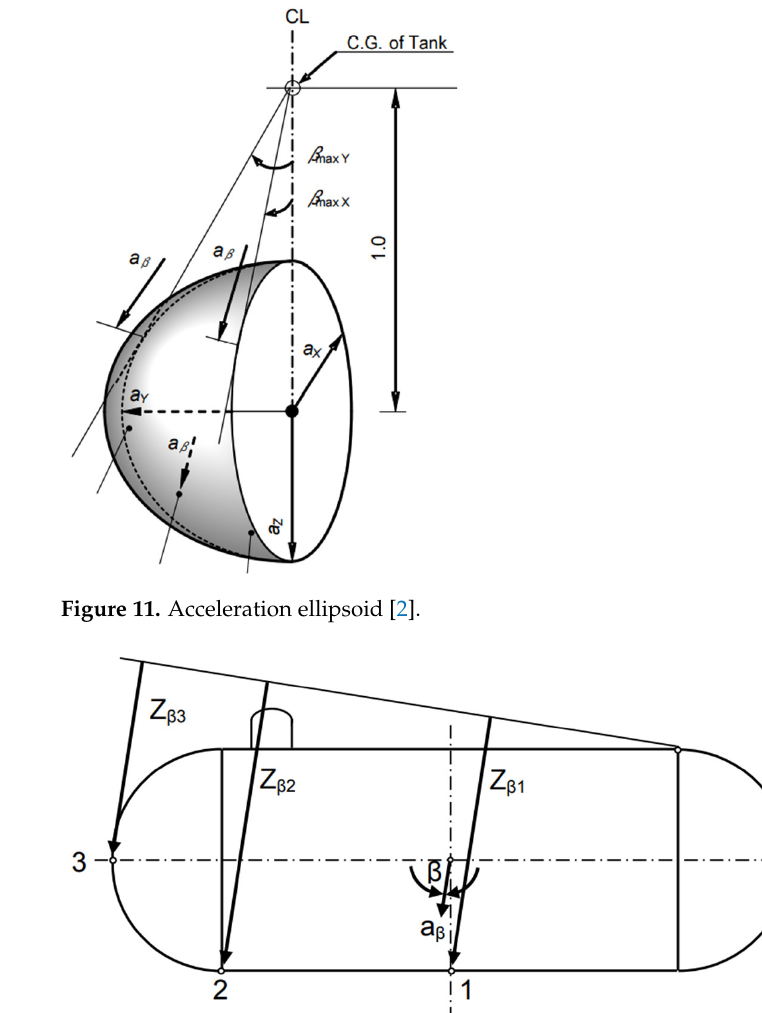
Figure 12. Determination of Z β [2].